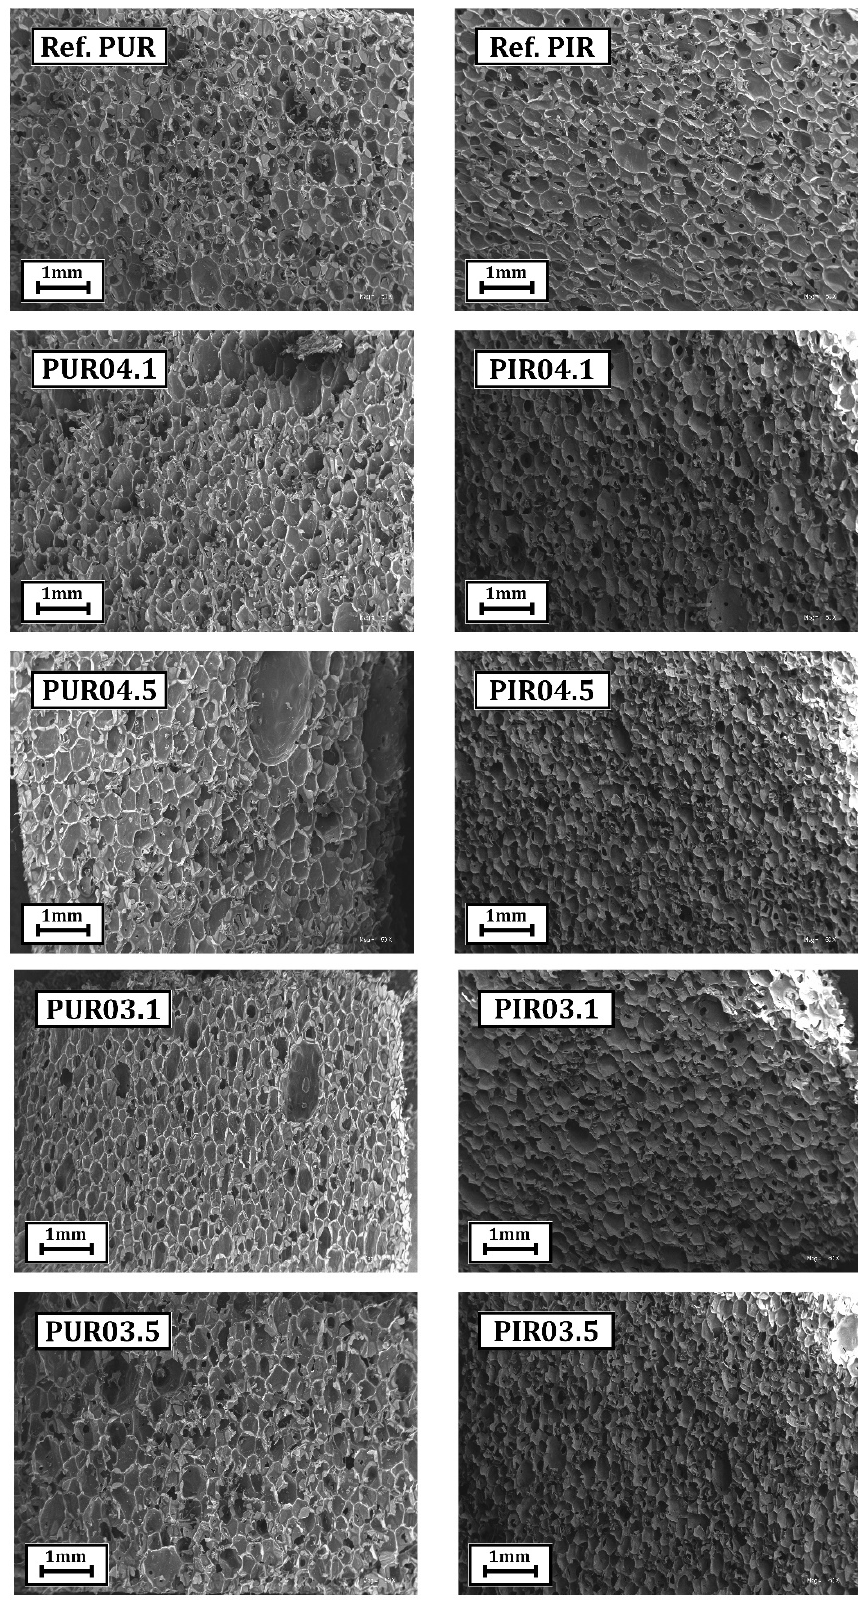
Figure 11. Micrographs of cellular structure of reference foams and foams modified by eco-polyols. Table 7. Results of SEM micrographs’ analysis.